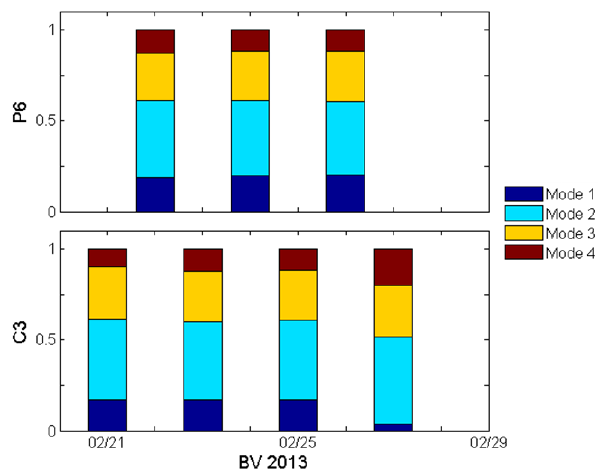
Figure 4. Number fraction of DMPS lognormal modes tested at SS = 0.08% for mesocosms C3 and P6 at